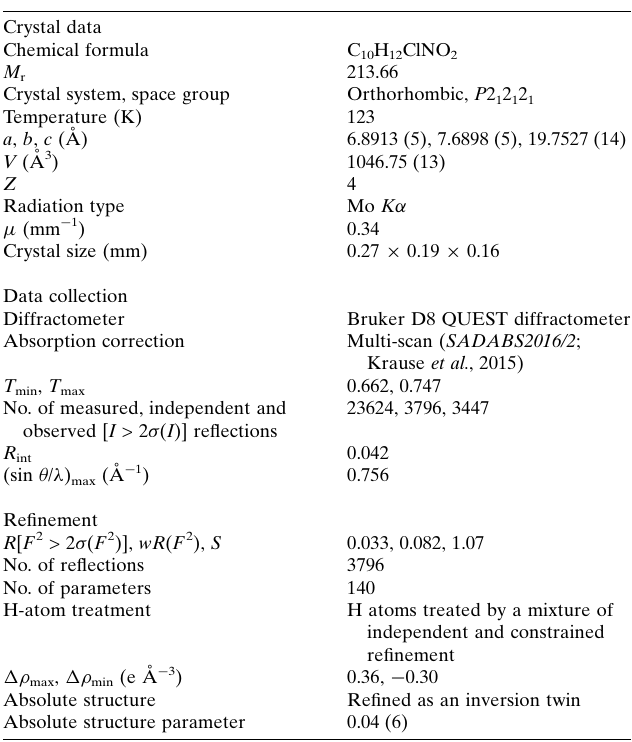
Table 2 Experimental details. Crystal data Chemical